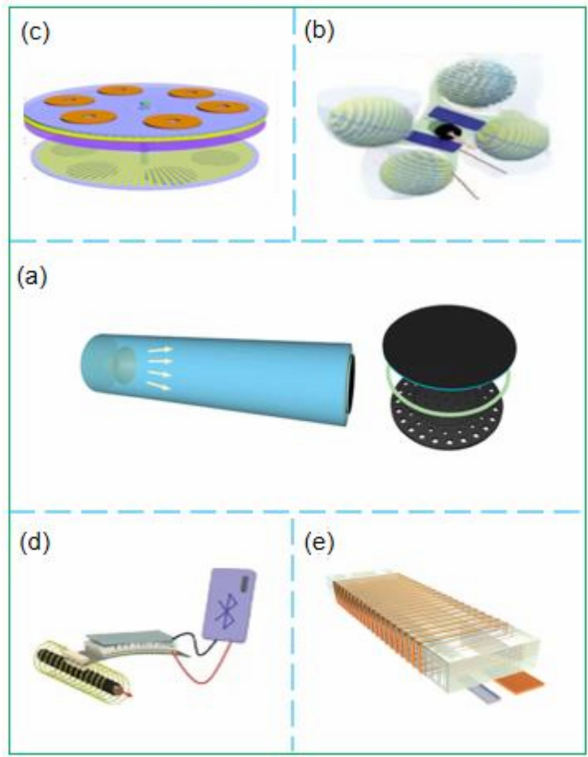
Figure 3. ( a ) Schematic illustration of the A-TENG device [95]; ( b ) Schematic illustration of the AoPS [96]; ( c ) Schematic illustration of the designed hybridized nanogenerator [97]; ( d ) Schematic illustration of the indoor wireless positioning system [99]; ( e ) Schematic illustration of the design and working mechanism of MDC-TENG [100]. ( a ) Reprinted with permission, LN: 5067400553203. ( b ) Reprinted with permission, LN: 5067401239029. ( c ) Reprinted with permission, LN: